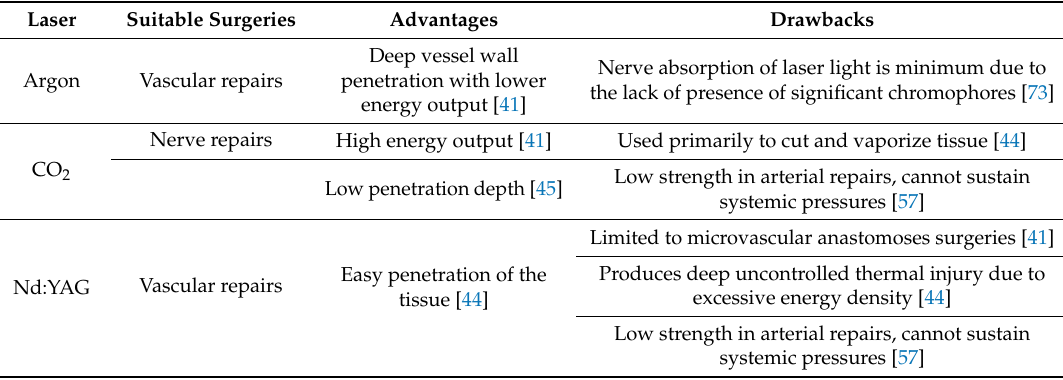
Table 3. Argon, CO 2 , and Nd:YAG characteristics in vascular and nerve laser-welding